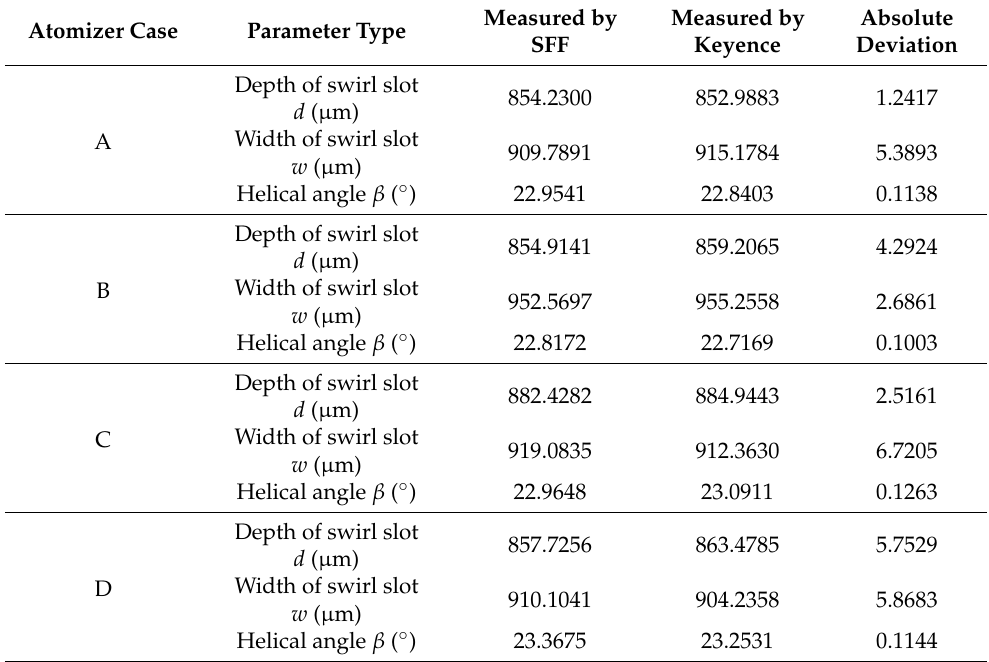
Table 4. Measurement result of swirl